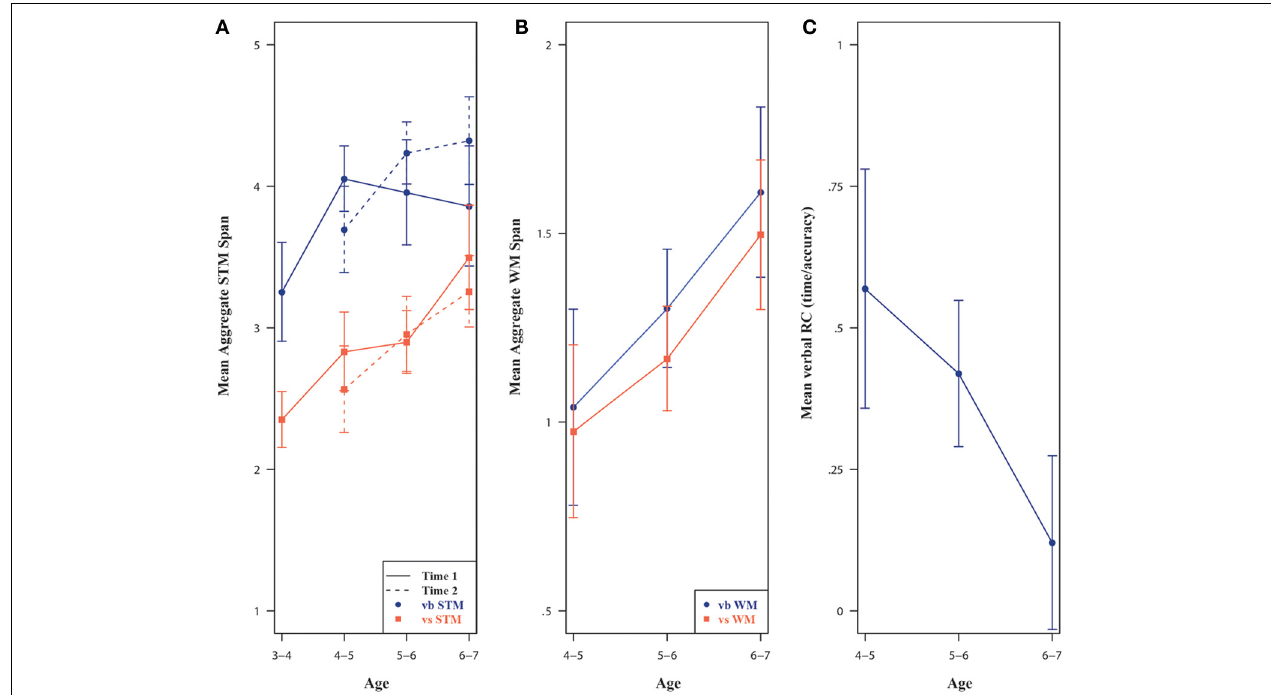
FIGURE 3 | Children’s mean STM (A), WM (B), and verbal response conflict (C) performances with 95% Confidence Intervals. Performance for verbal response conflict was assessed using the log inverse efficiency